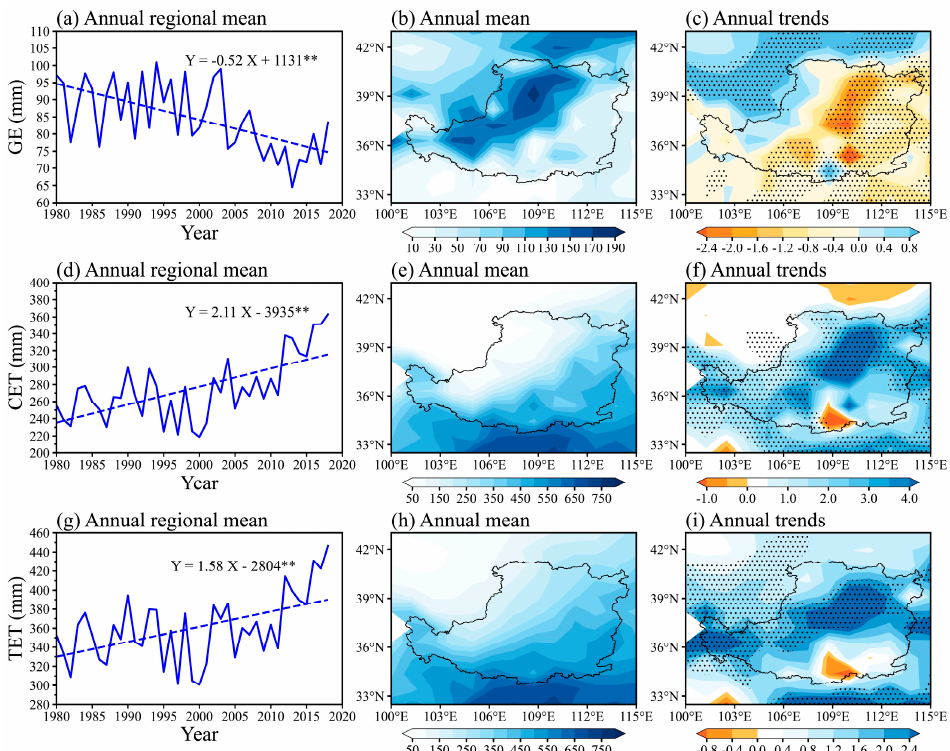
Figure 3. Spatiotemporal features of ET on the LP during the period of 1980–2018. The left column shows the area-averaged annual ( a ) ground evaporation, ( d ) canopy ET, and ( g ) total ET and their linear trends (unit: mm/year). Note that “**” indicates a statistically significant level ( p < 0.01); the middle column shows the spatial pattern of annual mean ( b ) ground evaporation, ( e ) canopy ET and ( h ) total ET; and the right column shows the spatial pattern of linear trends (unit: mm/year) for the ( c ) ground evaporation, ( f ) canopy ET and ( i ) total ET. Areas with a significant change ( p < 0.05) based on the t -test are stippled.